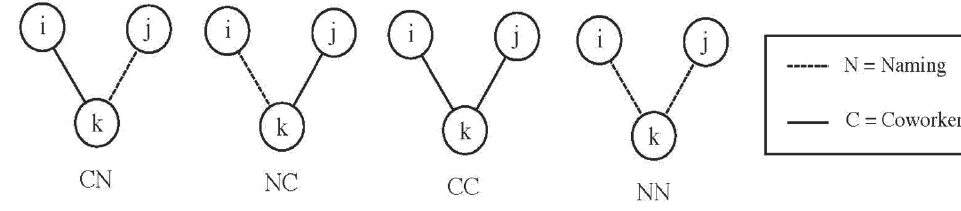
Figure 2: Types of Triadic Relationships